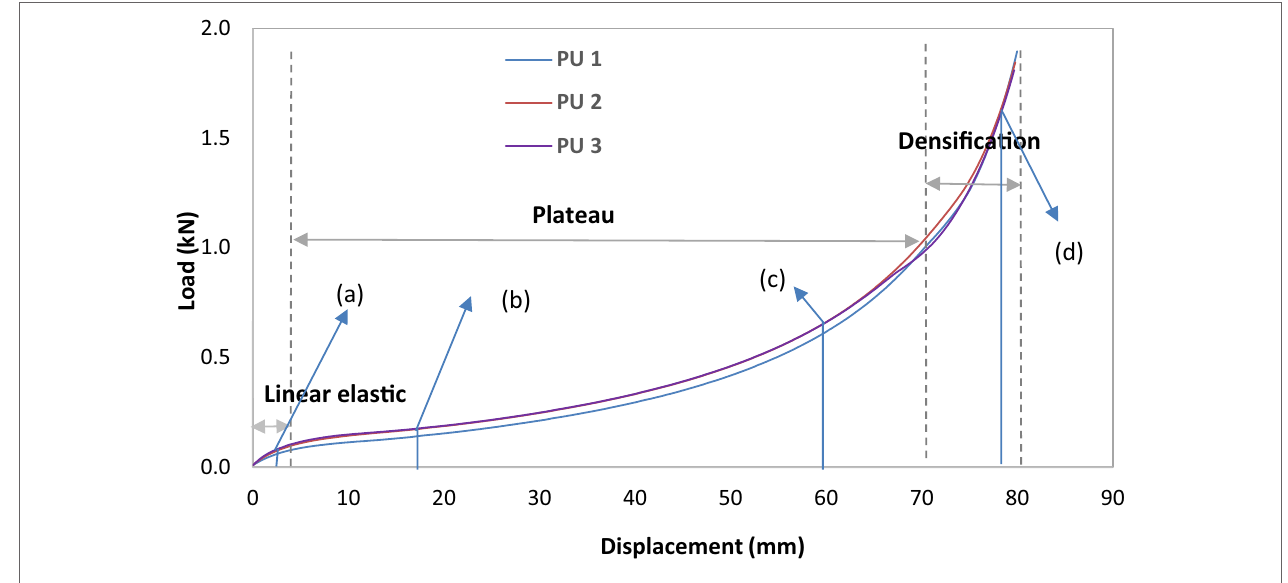
FigUre 3 | Typical axial compression load vs. displacement curve of foam